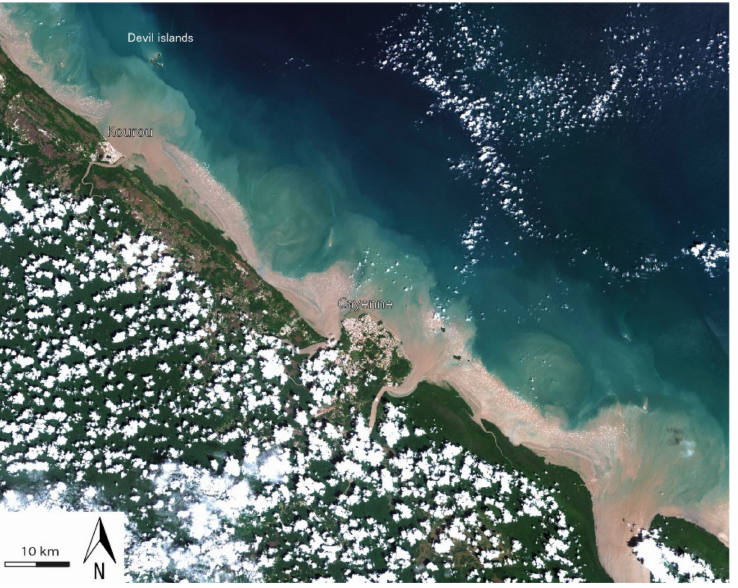
Figure 7. Copernicus Sentinel 2 satellite image (29 October 2019) showing a mud bank in transit along the coast of central French Guiana between the cities of Cayenne (capital of French Guiana) and Kourou (satellite launching pad of the European Union). This is part of a belt of up to 20 mud banks migrating at any time along the Guianas coast just north of the mouths of the Amazon to the mouths of the Orinoco River delta in